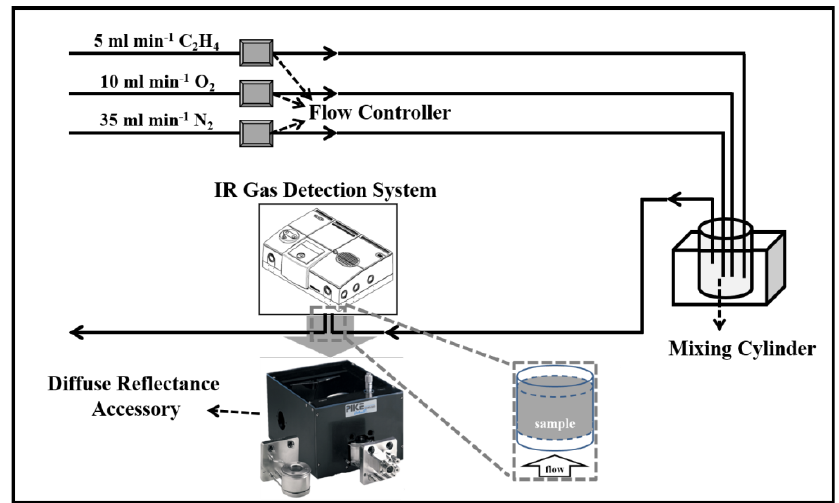
Figure 1. The testing system of in situ diffuse reflectance FT − IR spectroscopy.